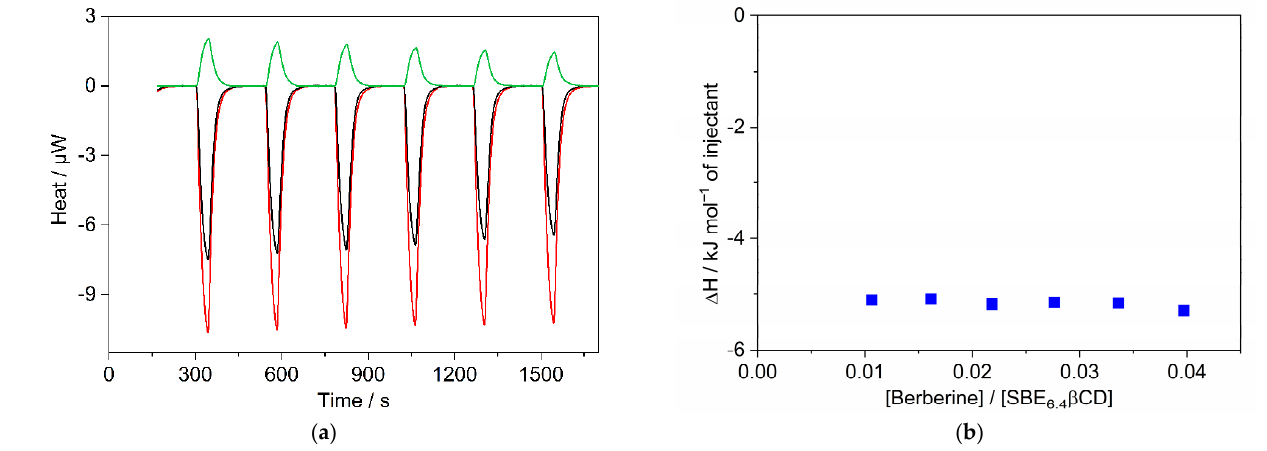
Figure 6. ( a ) ITC traces for the titration of 6.04 mM SBE 6.4 β CD solution with water (black line) and 1.12 mM B solution (red line). Absorbed heat upon the addition of 1.12 mM B solution into water (green line); 40 μ L aliquots were injected into 1.433 mL volume. ( b ) The integral of the evolved heat after subtraction of the dilution heats of B and SBE 6.4 β CD as a function of [B]/[SBE 6.4 β CD] molar